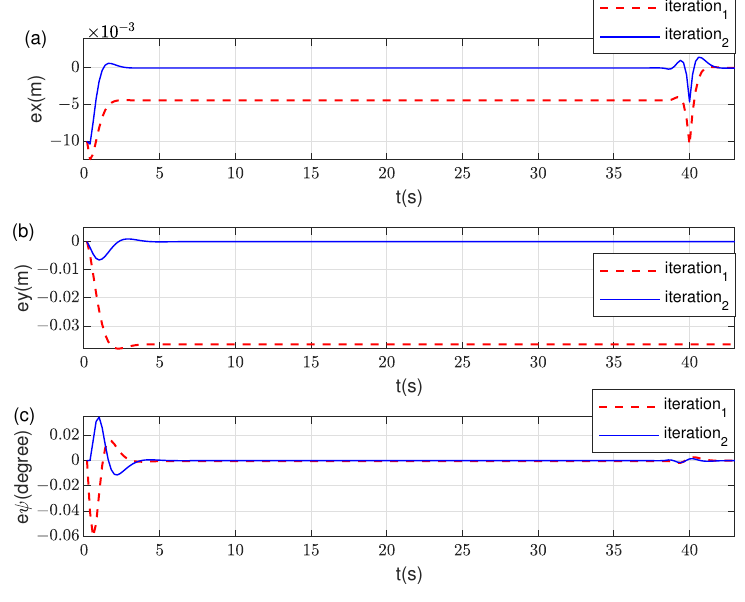
Figure 11. Tracking error under model mismatch: ( a ) longitudinal error; ( b ) lateral error; ( c ) heading angle